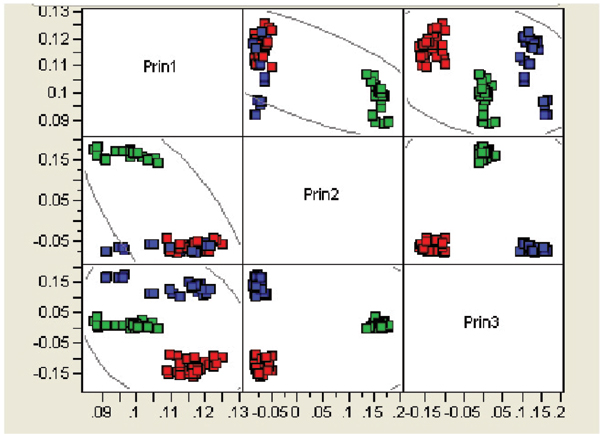
Principal components analysis of relatedness between microarray data. Each colored box represents an individual hybridization. Blue = liver tissue, Red = 24 hr exposed cells, and Green = 48 hr exposed cells. Prin1 = first principal component, Prin2 = second principal component, and Prin3 = third principal component.